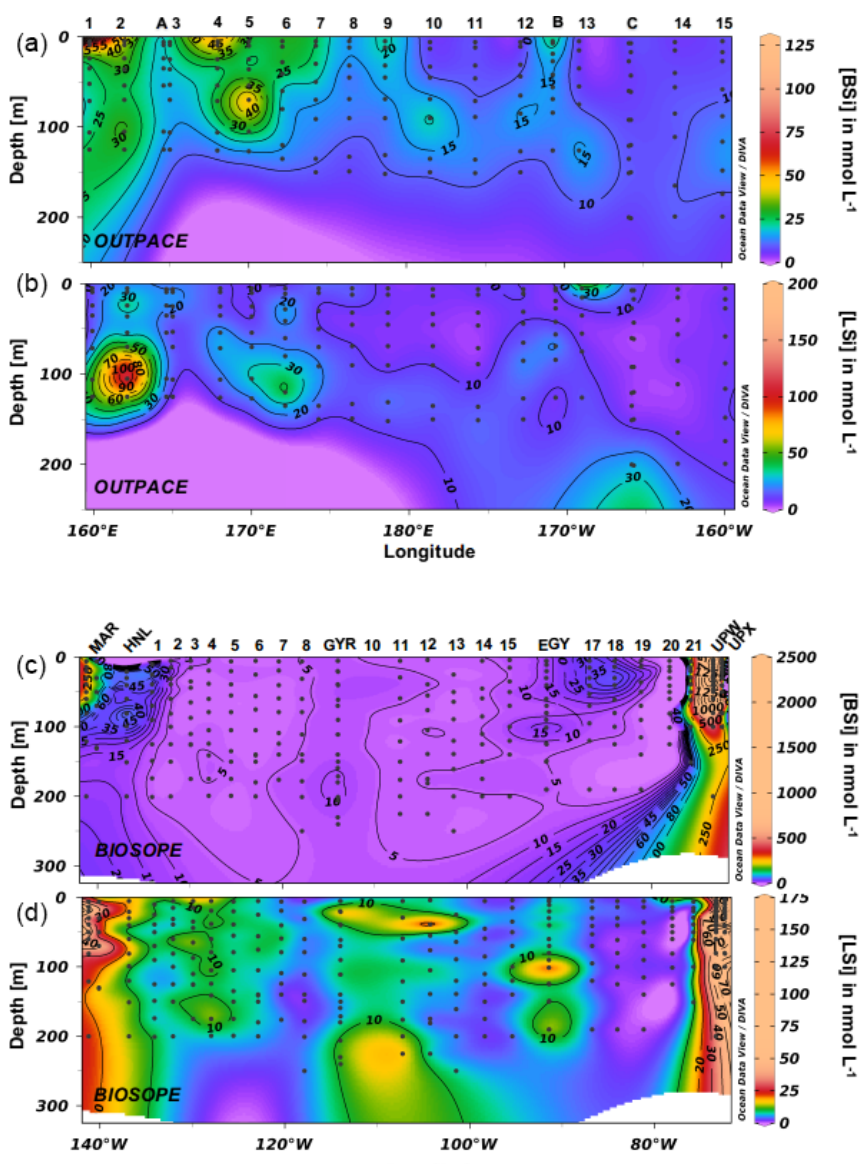
Figure 5. (a, c) Biogenic silica (BSi) and (b, d) lithogenic silica (LSi) distribution during the OUTPACE and BIOSOPE cruises (in nmolL − 1 ).